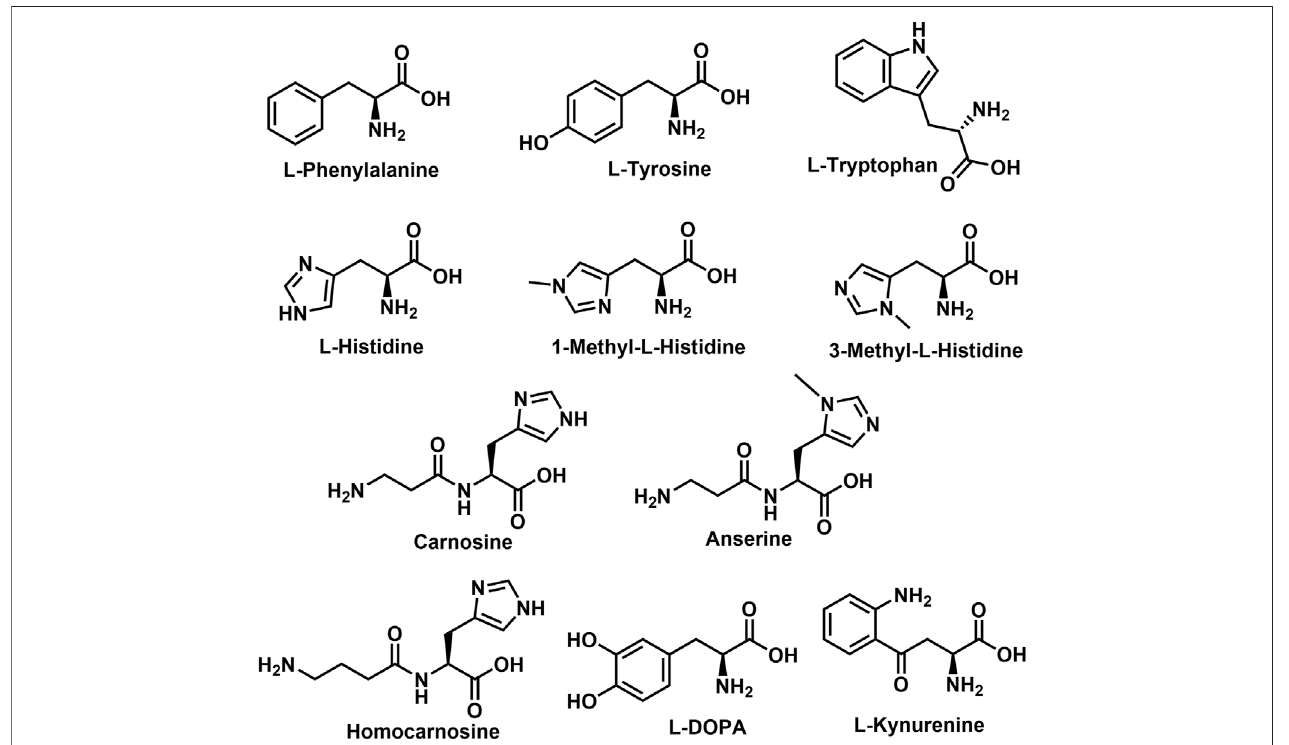
FIGURE 1 | Structures of the Aromatic Amino Acids and Aromatic Amino Acid related